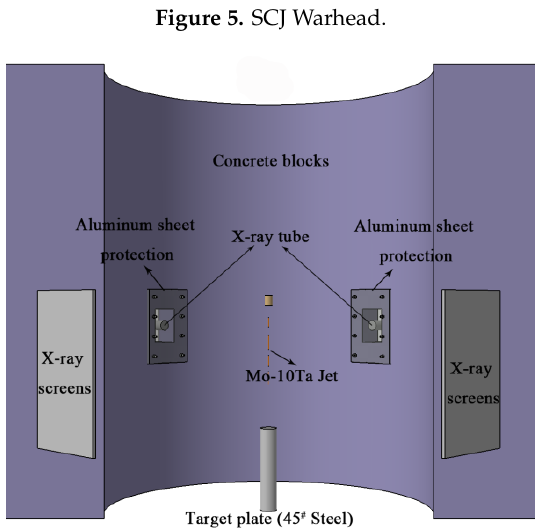
Figure 6. Explosive forming test layout.